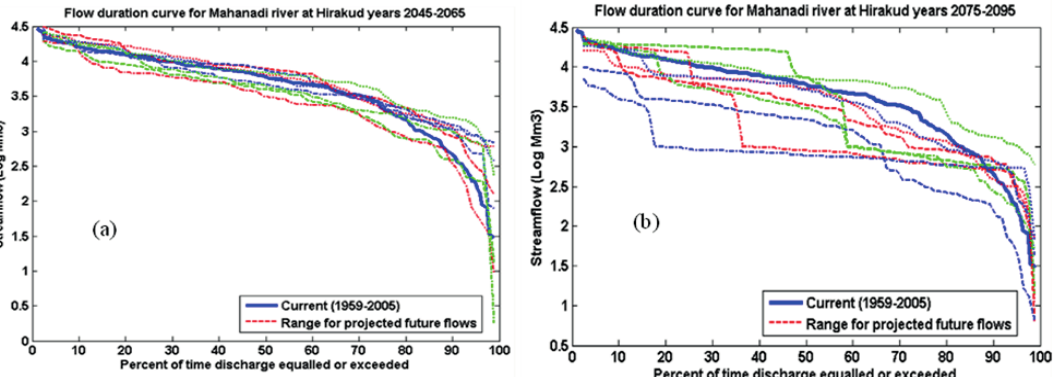
Fig. 1 Flow duration curves for Mahanadi River for current and future time slices (source: Raje and Mujumdar